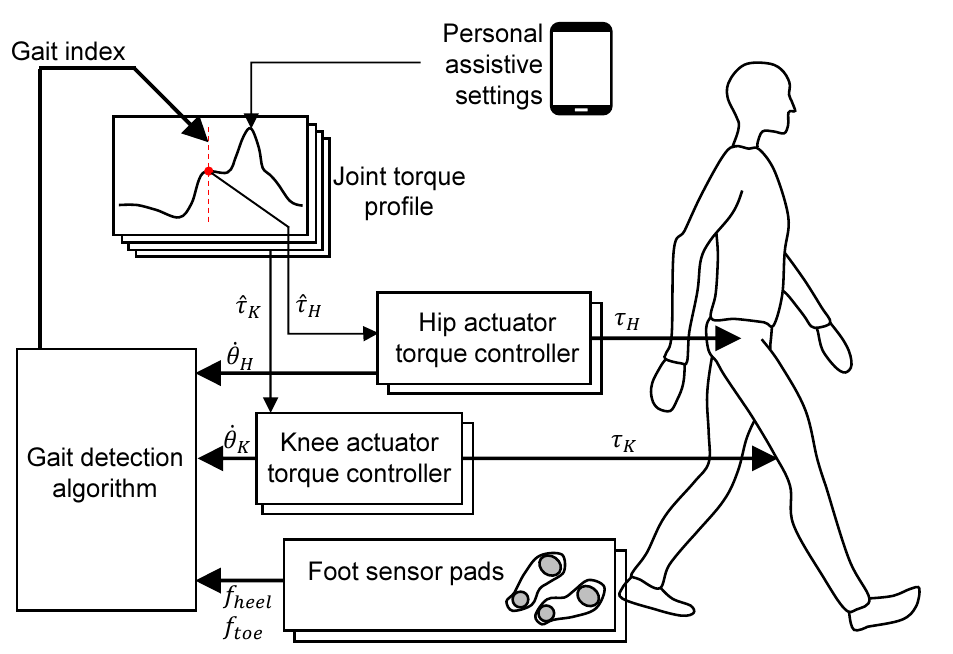
Figure 7. The overall control structure of Angel